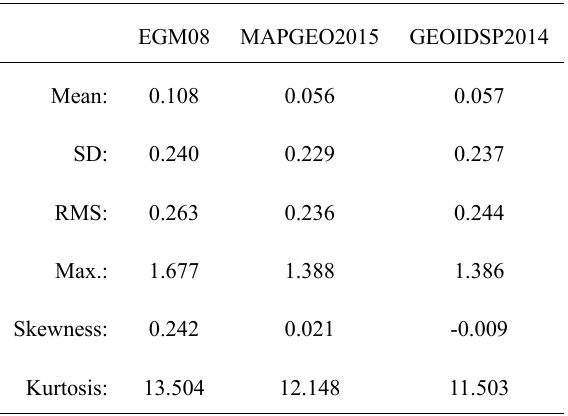
Consistency (in meters) of gravimetric geoids EGM08, MAPGEO2015 and GEOIDSP2014 in relation to tracked leveling points in the State of São